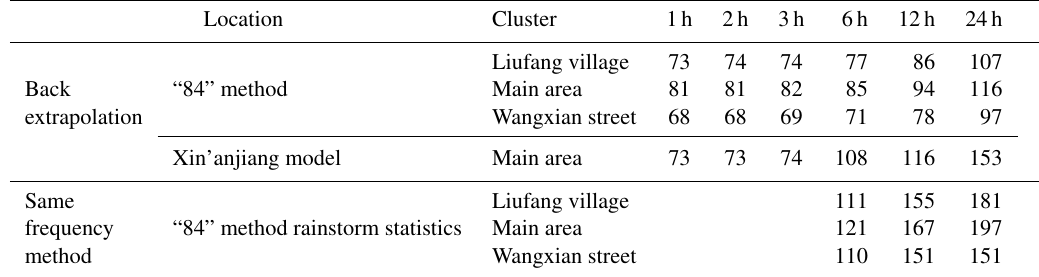
Table 4. Rainfall warning threshold of downtown area in Shitai and upstream and downstream related